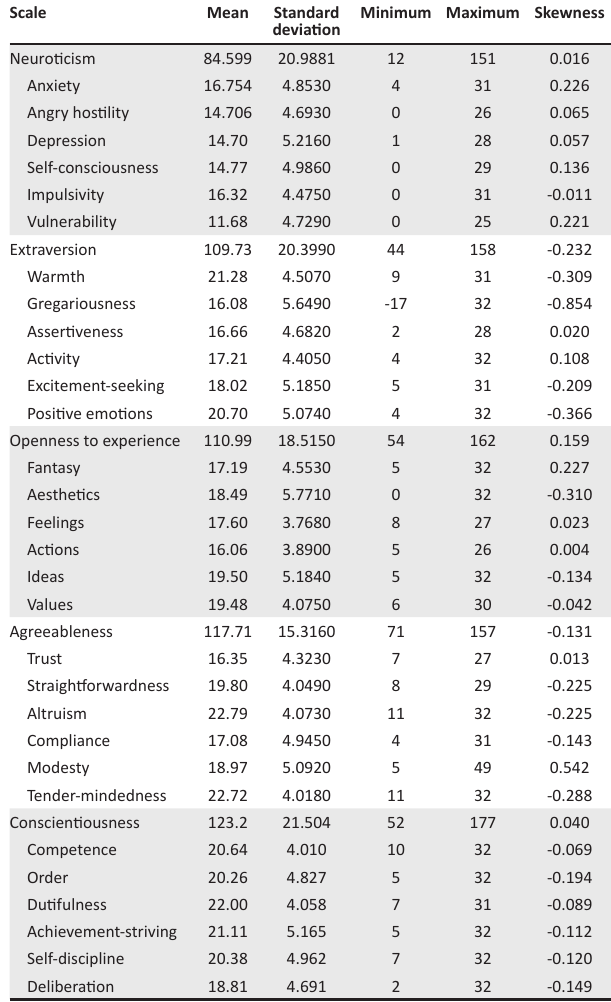
TABLE 2: Descriptive statistics for the NEO-PI-3.